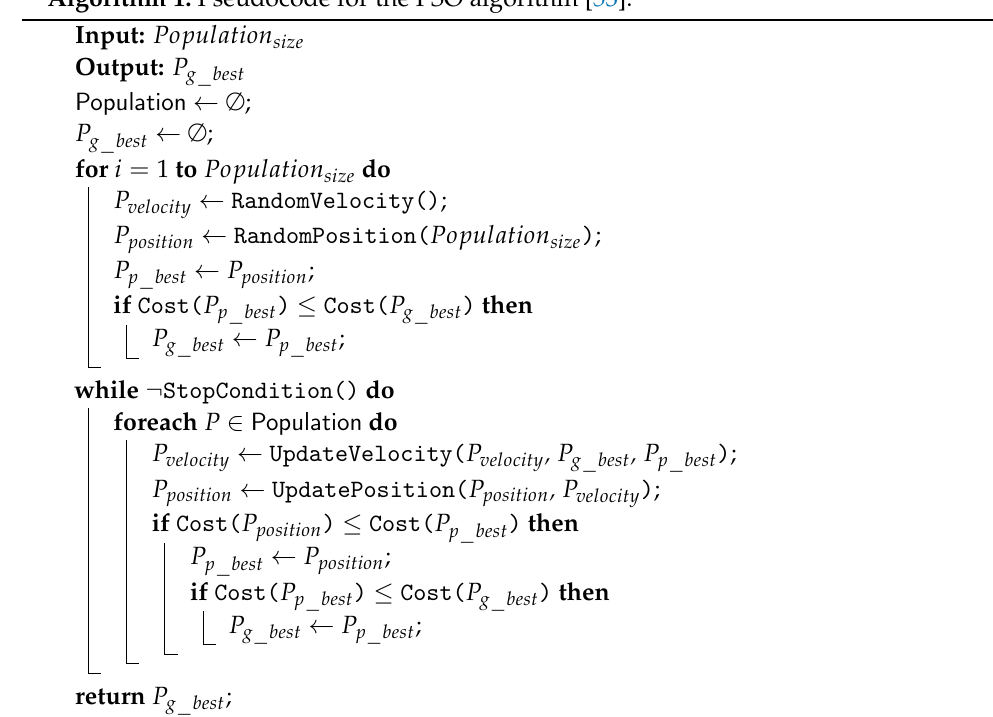
Algorithm 1: Pseudocode for the PSO algorithm